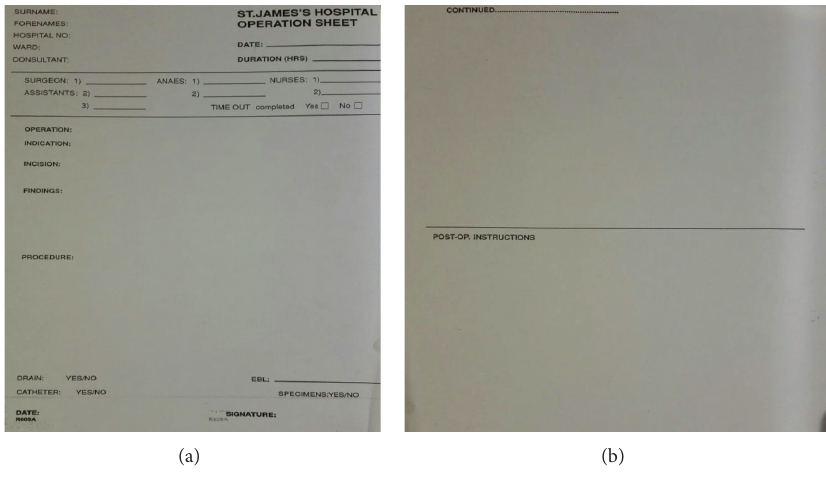
Figure 1: St. James’s Hospital operation proforma: front and